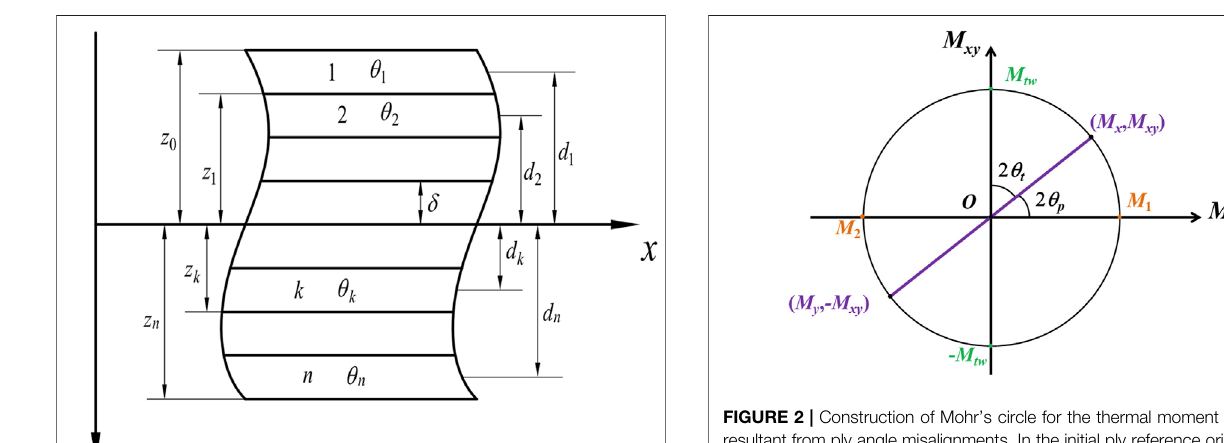
FIGURE 2 | Construction of Mohr ’ s circle for the thermal moment resultant from ply angle misalignments. In the initial ply reference orientation, there are the bending moments M x and M y and the twisting moment concurrently;inaninclinedsurfacewithrotationangle θ t (or θ p )infactand 2 θ t (or 2 θ p ) in fi gure, there is only the maximum twisting moment M tw (or the principal moment M 1 and M 2 ). FIGURE 1 | Coordinate system and the ply number for a laminate. θ k